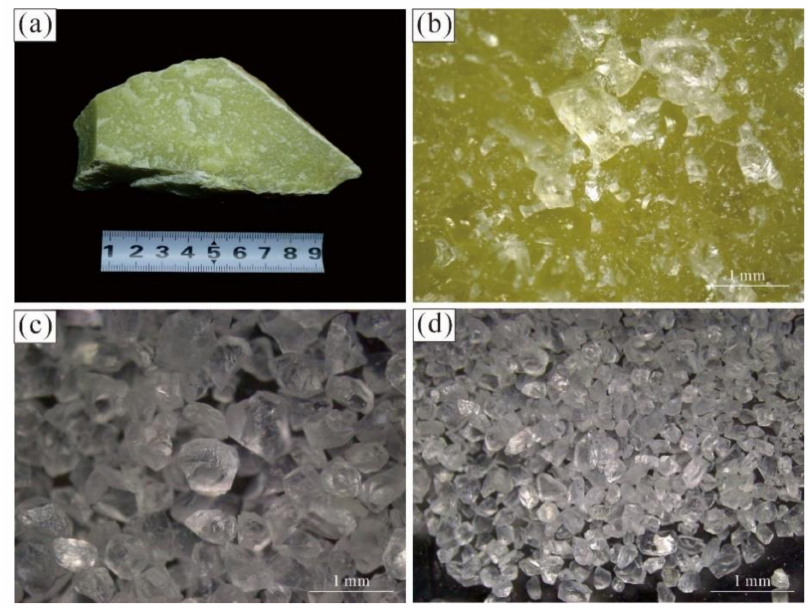
Figure 1. Sample photographs. ( a ) the Jian forsterite jade. ( b ) 40 × magnification observation of ( a ) under gem microscope. ( c ) and ( d ) hand-picked B-rich